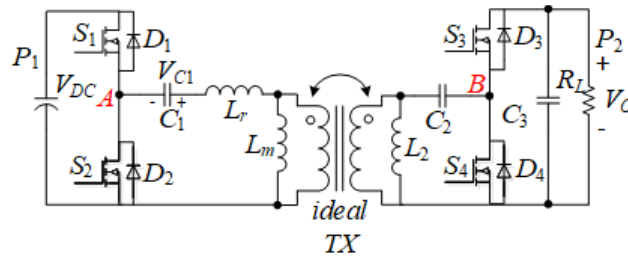
Figure 4. Forward equivalent